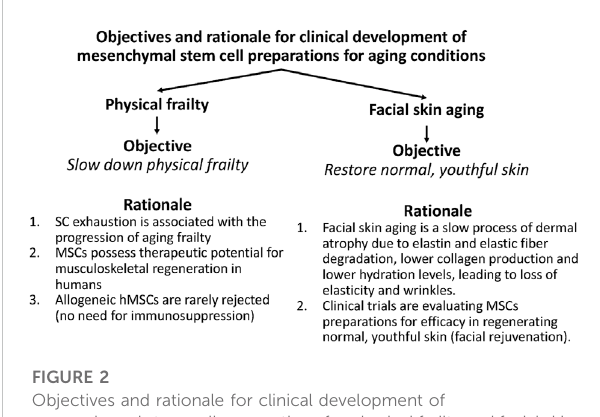
FIGURE 2 Objectives and rationale for clinical development of mesenchymal stem cell preparations for physical frailty and facial skin